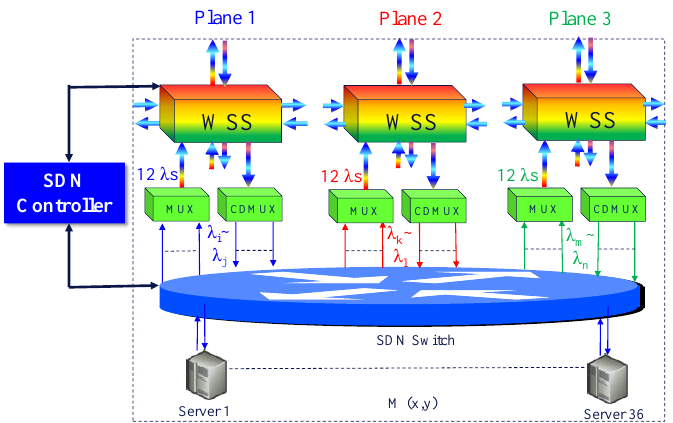
Figure 8. A module of Three-plane Torus topology optical tunnel switching network.